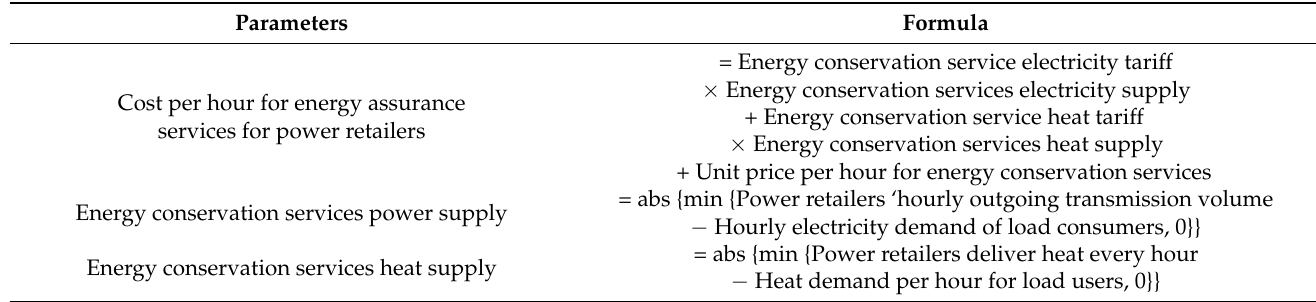
Figure 6. Stock flow map of energy conservation services. Table 3. Mathematical model for energy conservation services.